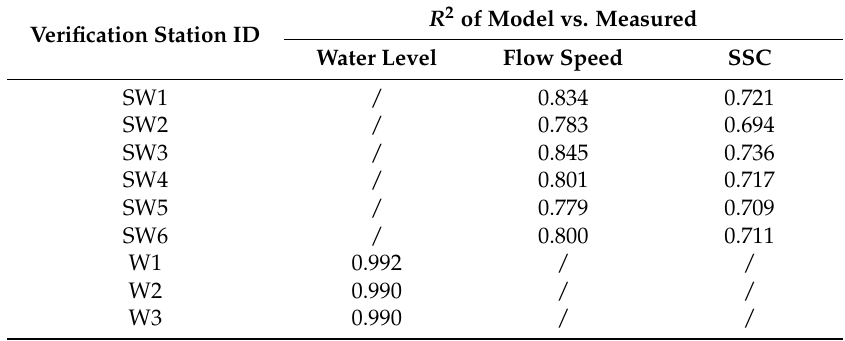
Table 2. Correlation coefficients ( R 2 ) between modeled and measured data at stations.